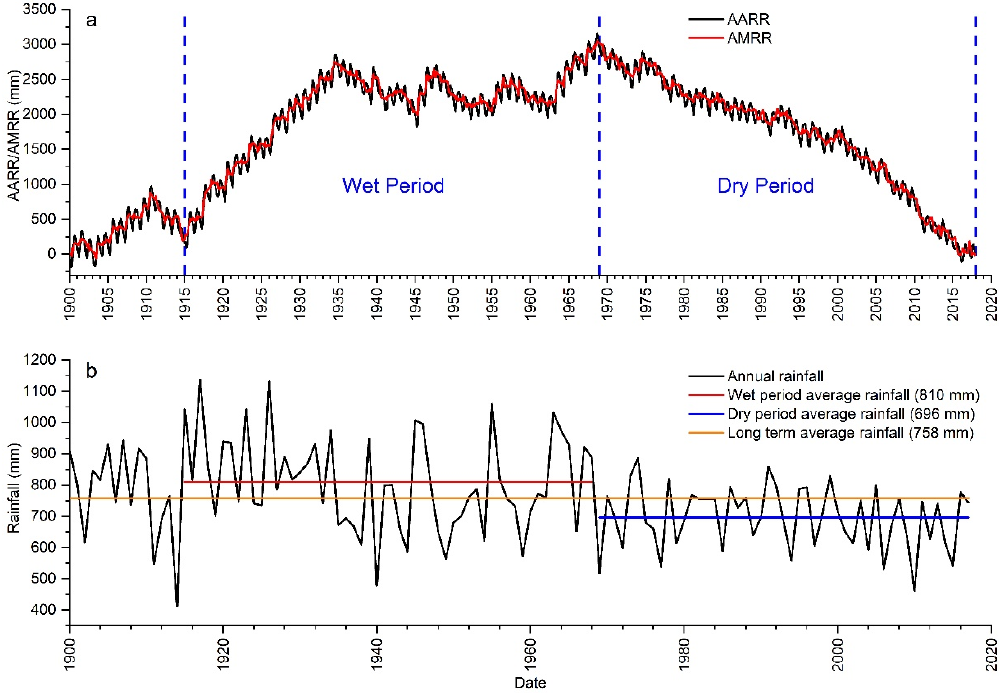
Figure 15. The rainfall in dry and wet climatic periods shown by the Hydrograph Analysis: Rainfall and Time Trends (HARRT) ( a ), and the long-term, wet period and dry period mean rainfall ( b ) in the Gnangara region.